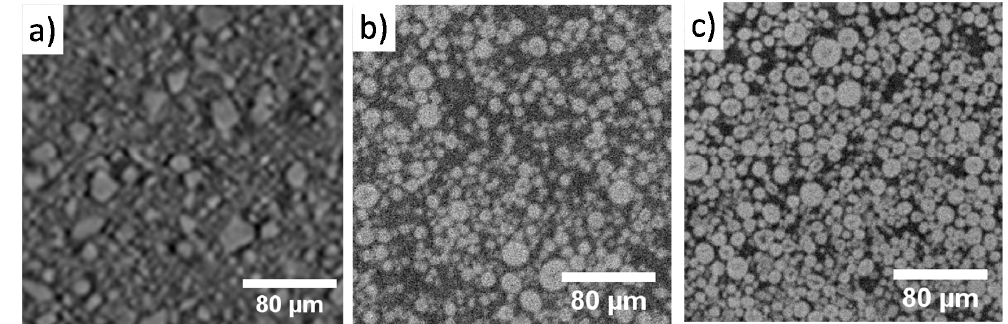
Figure 8. Improvement in image quality between ( a ) coin cell scan performed at a synchrotron facility for an LMO electrode, ( b ) Swagelok-type PFA cell, and ( c ) PEEK cell scans performed with a laboratory